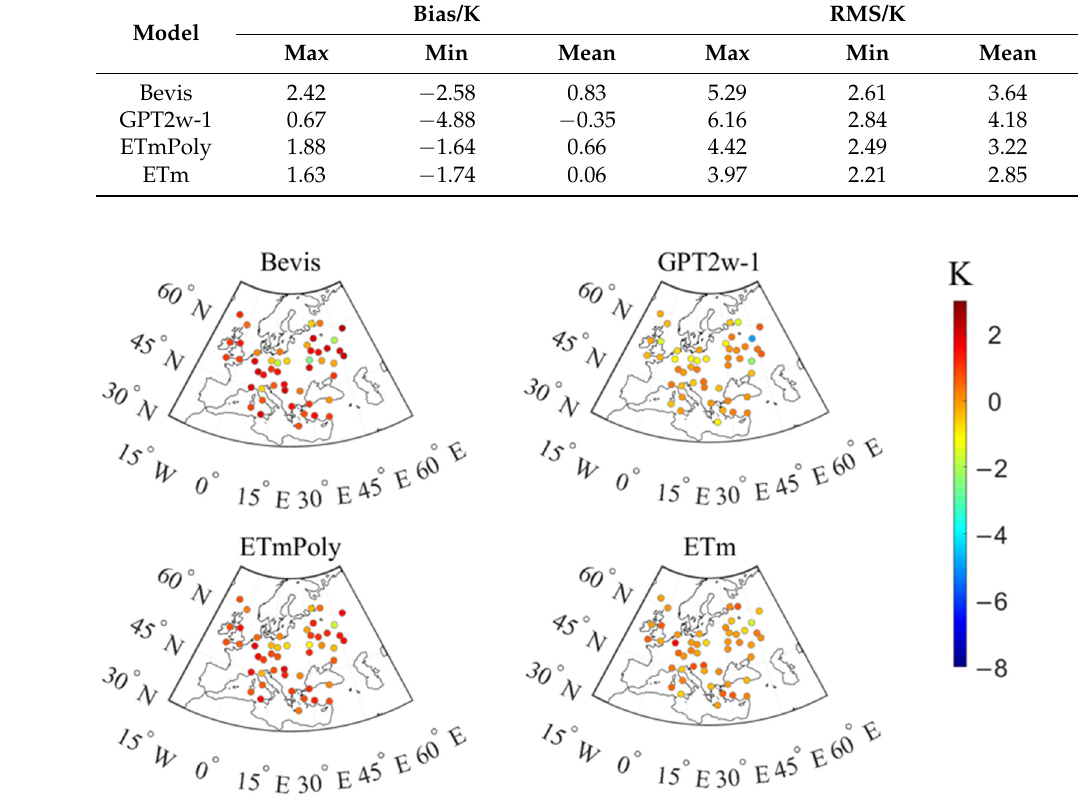
Figure 3. Bias distribution of the four Tm models at each modeling station in 2021.